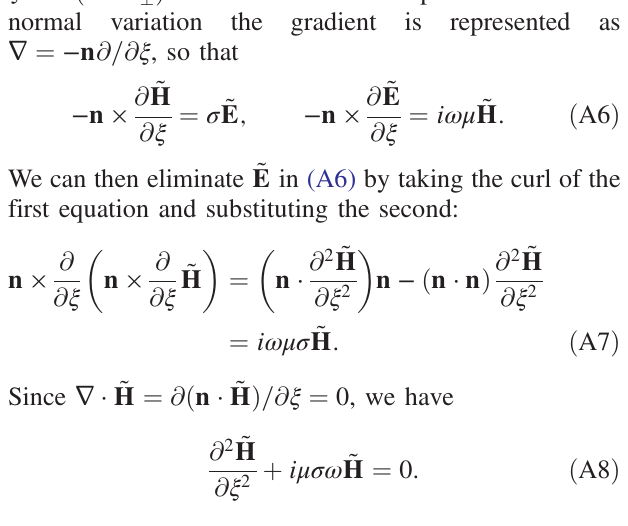
k; s ; x; g Þ as a function of x at k σ x ð b